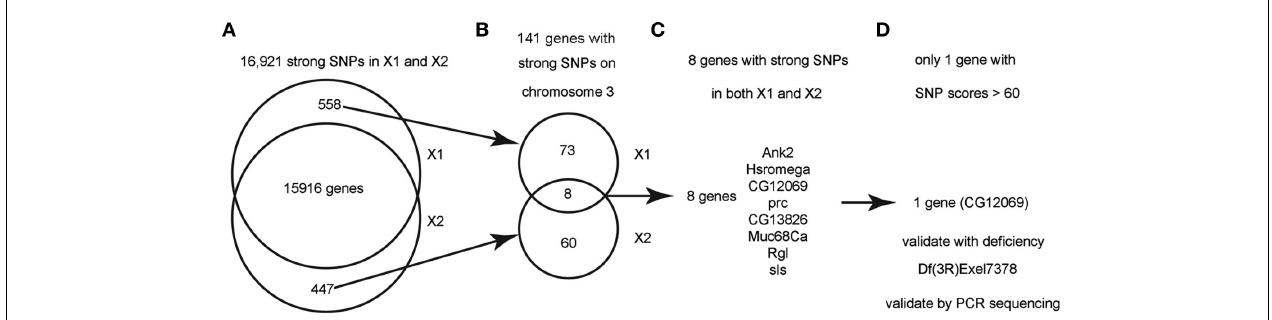
FIGURE 3 | Flowchart for finding the causative SNPs in X1 and X2. (A) SnpEeff identified 16,921 “class 1” SNPs (see text) with a quality score > 1 in both X1 and X2 (zero quality scores are usually resulted from reads mapping to multiple genomic regions).There are 558 SNPs that are only present in X1 and 447 SNPs that are only present in X2. (B) Since we know that X1 and X2 are on chromosome 3, we focused on the 141 strong SNPs on chromosome 3 that are present in X1 or X2 but not both.There are only eight